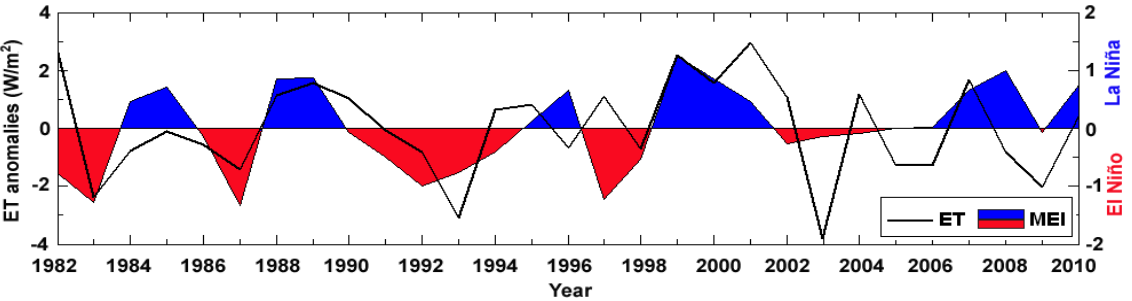
Figure 6. Inter-annual variability of ET and MEI for 1982–2010.